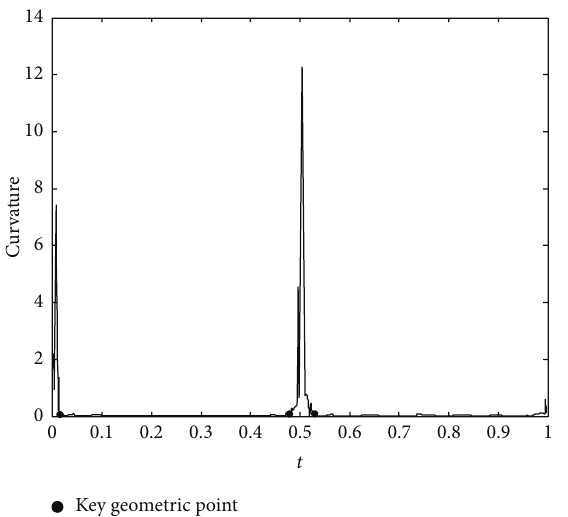
Figure 15: Key geometric points.